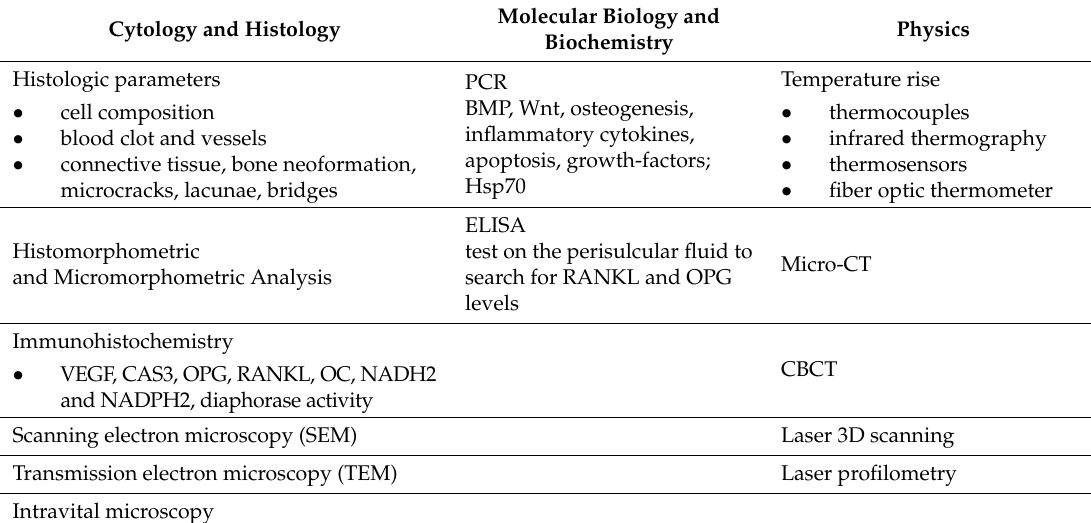
Table 1. Main investigations for heat-related bone tissue